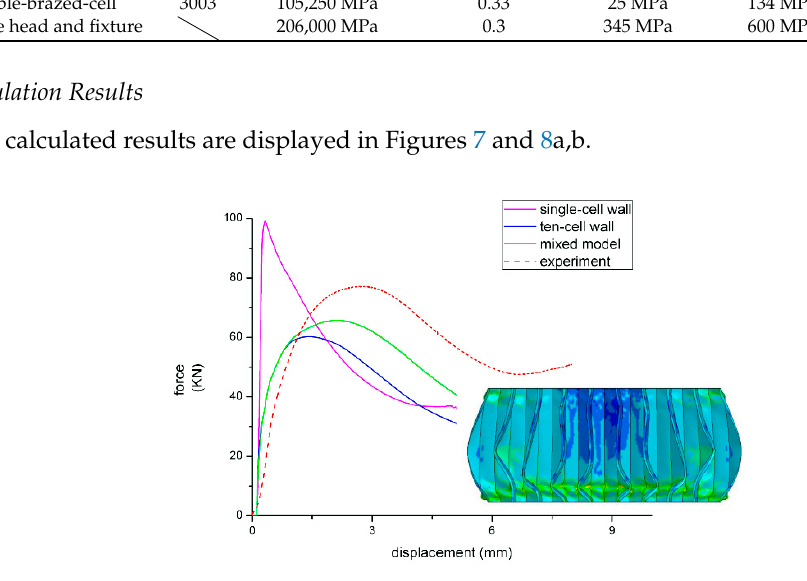
Figure 6. ( a ) Finite element model under out-of-plane compression ( b ) Finite element model under in-plane compression in transverse and longitudinal directions.